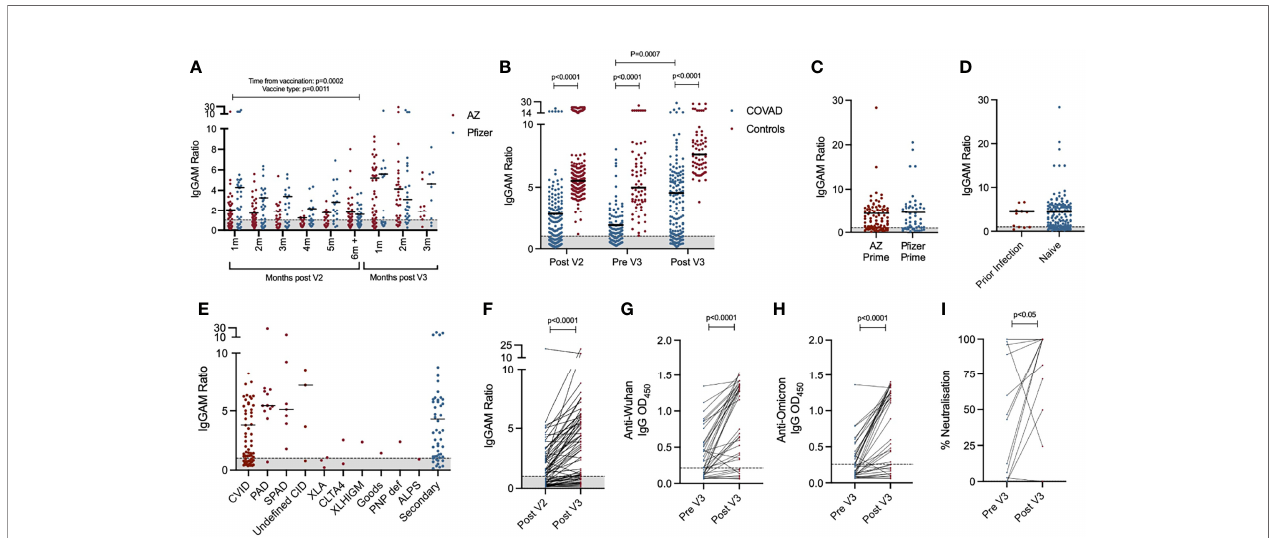
FIGURE 1 | Serological response to third primary immunisation in COV-AD participants: (A) Total anti-SARS-CoV-2 spike glycoprotein antibodies in all participants sampled throughout the COV-AD study presented by time of sampling relative to V2 and V3. (B) Comparison of total anti-SARS-CoV-2 spike serological responses of infection naive COV-AD participants and healthy controls 1-2 months post second vaccine dose (Post V2), up to 1 month prior to third vaccine dose (Pre V3) and 1-2 months post third vaccine dose (Post V3). (C) Comparison of total anti-SARS-CoV-2 spike serological responses of infection naive COV-AD participants 1-2 months post third vaccine dose by initial two-dose vaccine received. (D) Comparison of total anti-spike serological responses of COV-AD participants 1-2 months post third vaccine dose by prior infection status. (E) Comparison of total anti-spike serological responses of infection naive COV-AD participants 1-2 most post third vaccine dose by underlying immunode fi ciency. (F) Comparison of total anti-spike antibody levels of paired samples taken 1-2 months after the second vaccine dose and 1-2 months after the third vaccine dose. (G) Comparison of IgG binding to the original Wuhan SARS-CoV-2 spike glycoprotein between paired samples taken before and after third primary immunisation. (H) Comparison of IgG binding to the B.1.1.529 (Omicron) SARS-CoV-2 spike glycoprotein between paired samples taken before and after third primary immunisation. (I) Neutralisation capacity of paired serum samples taken before and after third vaccine dose against SARS-CoV-2 in a live virus neutralisation assay. In all cases, the grey shaded area represents the assay